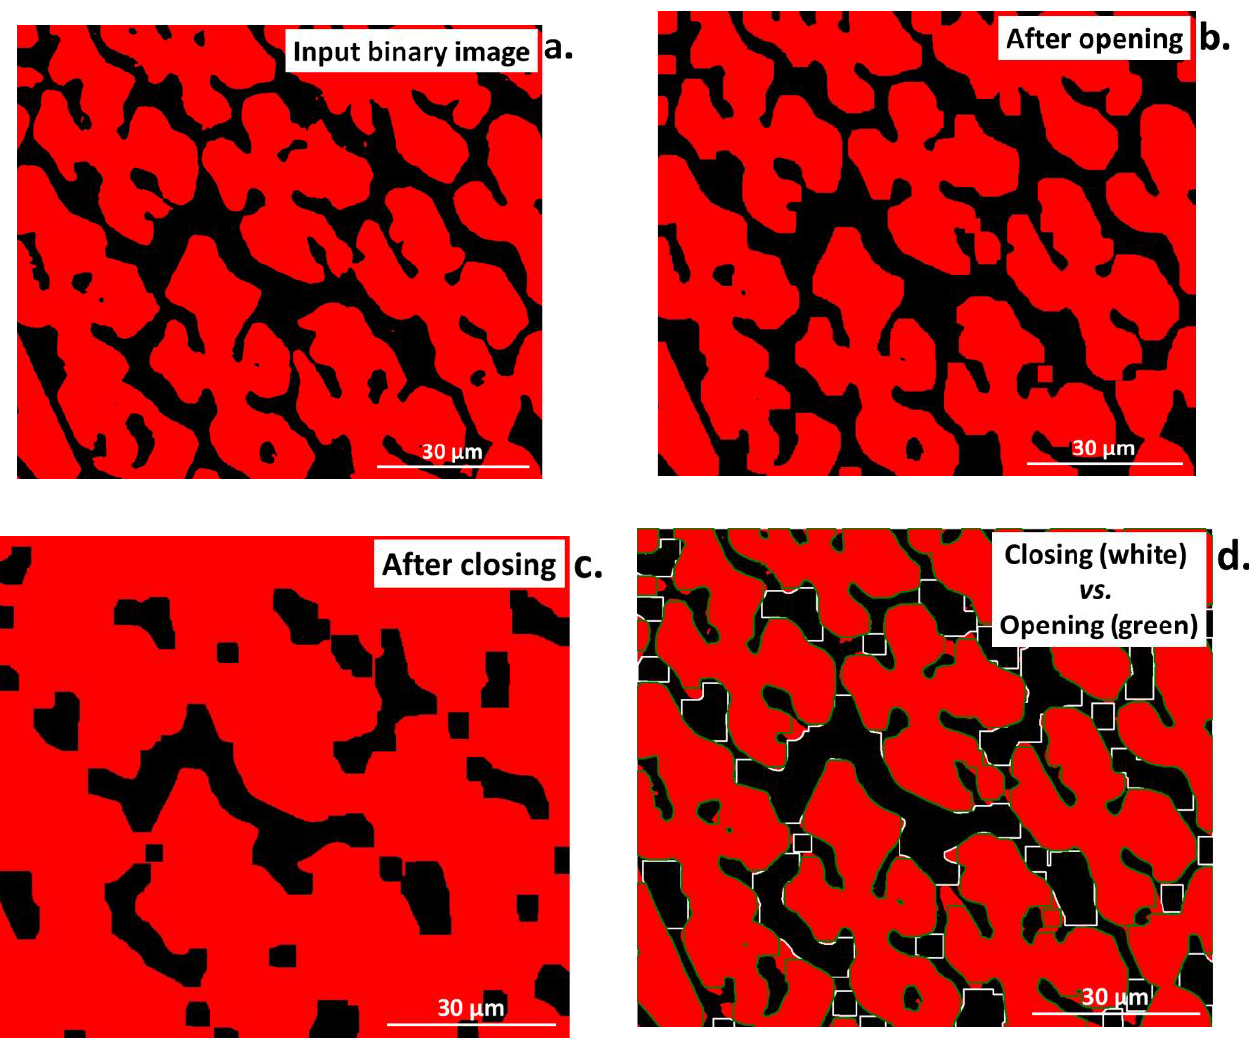
Figure 8. Comparison of the ( a ) input image after Otsu binarization to images after ( b ) opening, ( c ) closing, and ( d ) closing (while lines) and opening (green lines) superimposed on the input binary image.